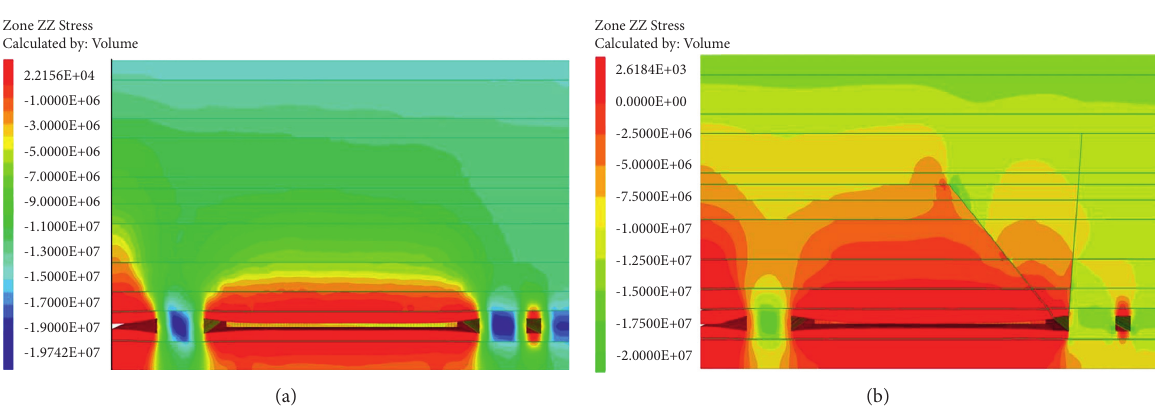
Figure 7: Nephogram of vertical stress of roadway surrounding rock (a) before and (b) after hydraulic